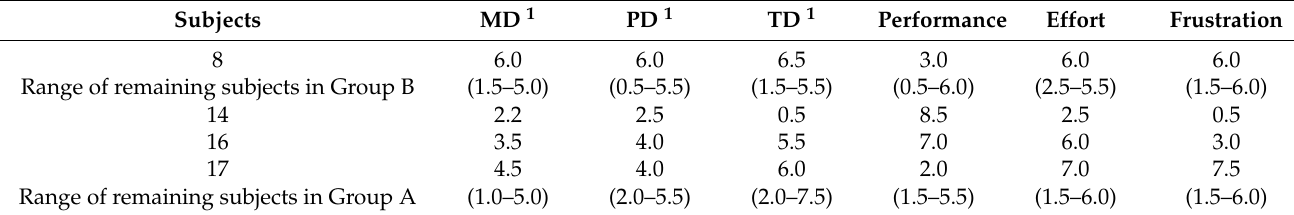
Table 3. Nasa-TLX scores for NP Task in Session